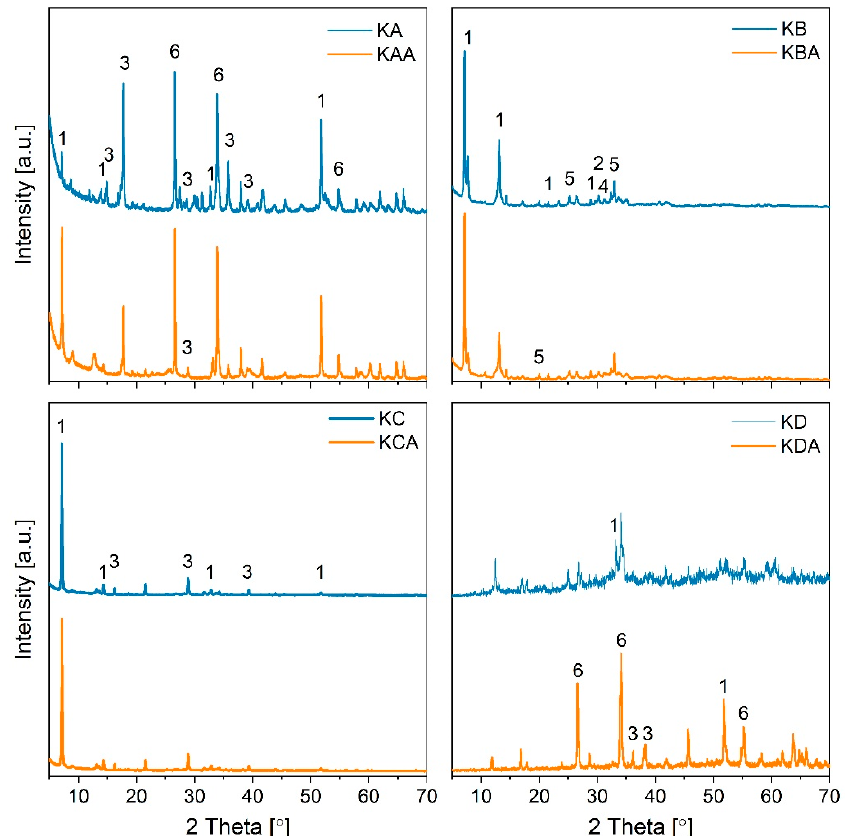
Figure 6. XRD of in-house synthesised sorbents K-A (KA), K-B (KB), K-C (KC), and K-D (KD) and same sorbents after 3 cycles at 850 ◦ C-ads/950 ◦ C-des. 1-K 2 SnO 3 ; 2-KOH; 3-K 2 Sn 3 O 7 ; 4-K 2 CO 3 ; 5-K 4 SnO 4 ; 6-SnO 2